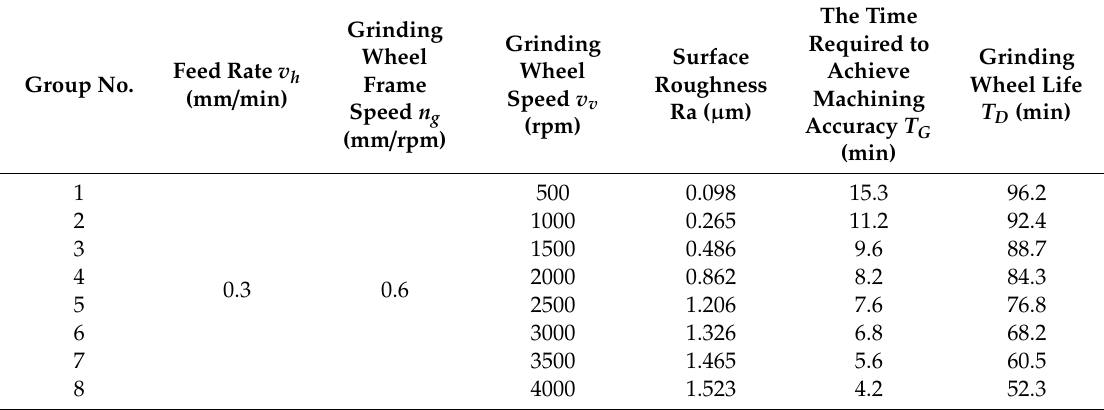
Table 6. The experiment grouping and results of exploring the impact of the grinding wheel speed.